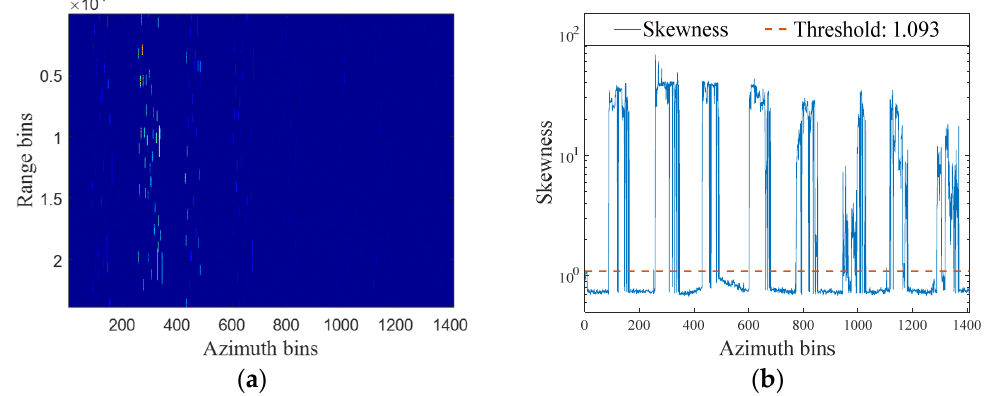
Figure 19. The WBI detection results on the measured SAR data corrupted with WBI: ( a ) the WBI- contaminated data in the two-dimensional time domain; ( b ) the WBI detection results via the TF skewness detection algorithm.